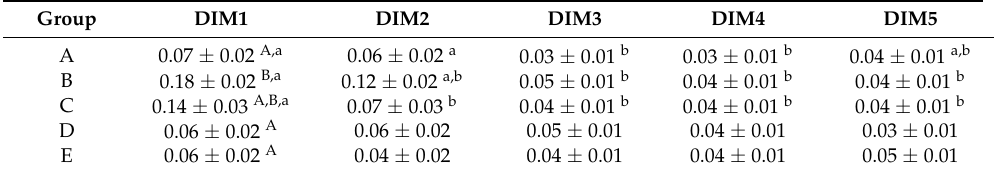
Table 2. BHB concentration (mmol/L) pattern by group over the first five months of lactation. Group DIM1